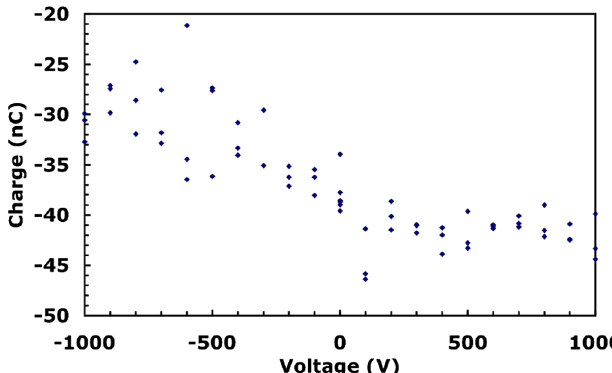
FIG. 9. (Color) Charge collected as a function of bias voltage for electrode 2.